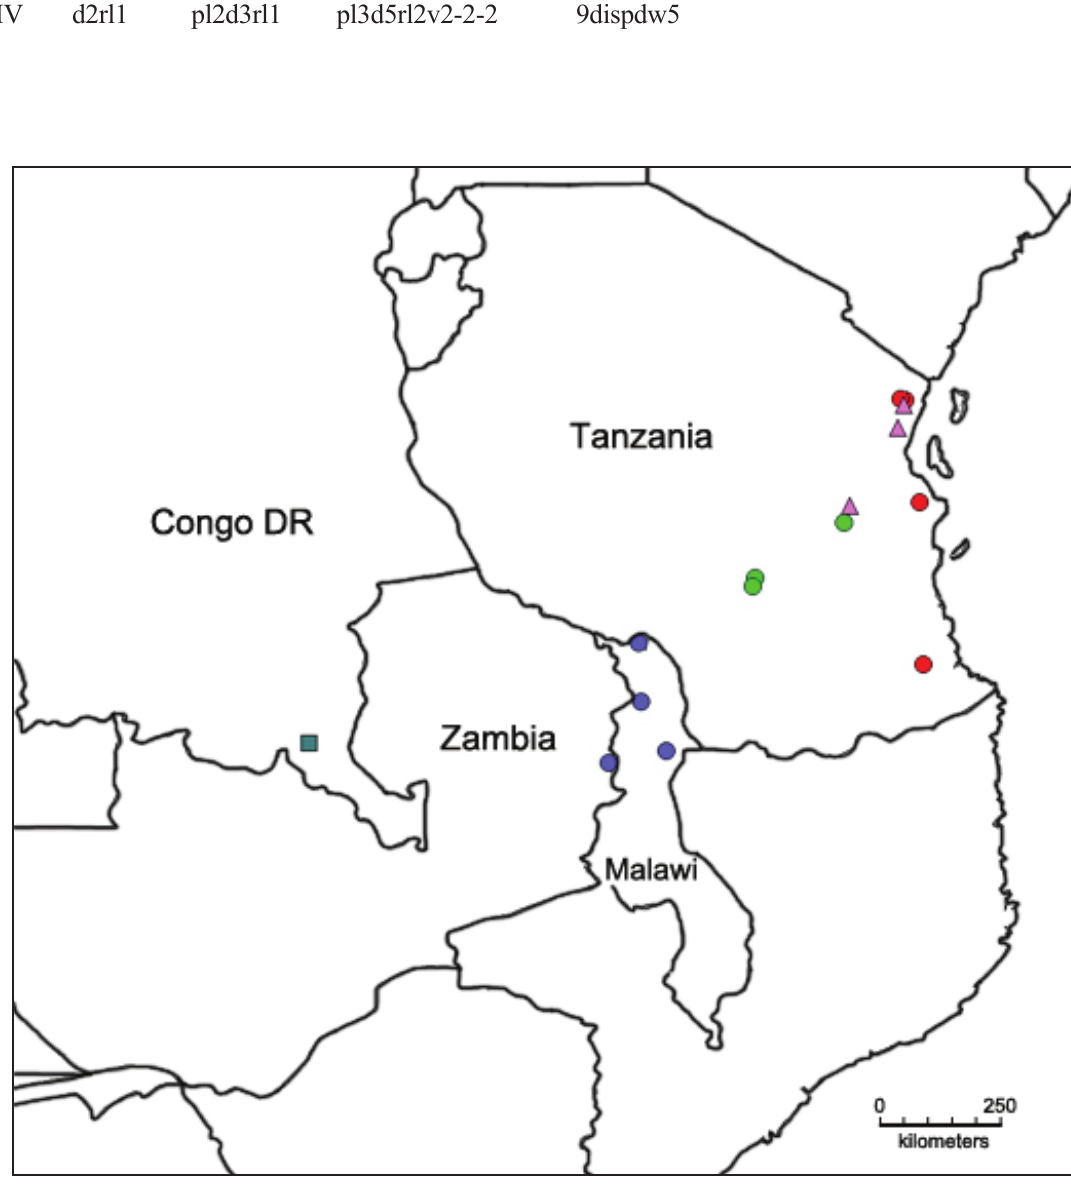
Fig. 16. distribution map of P. avonova gen. et sp. nov. ( ●), P. aleykyela gen. et sp. nov. ( ●), P. morogorom gen. et sp. nov. ( ●) , P. obmoimiombo gen. et sp. nov. ( ■) and P. sinis gen. et sp. nov. (